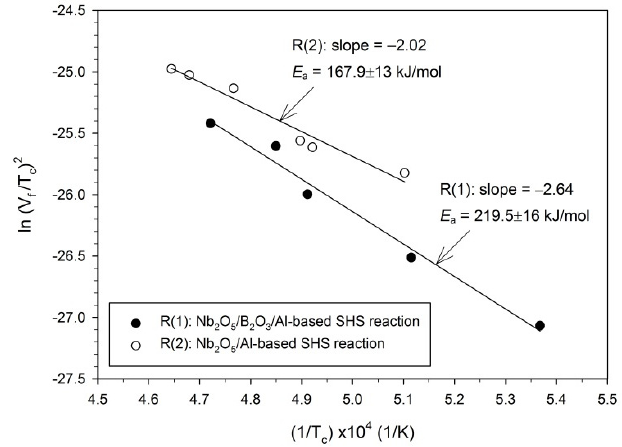
Figure 5. Correlation between combustion wave velocity and temperature for determination of activation energies ( E a ) of Reactions (1) and (2).